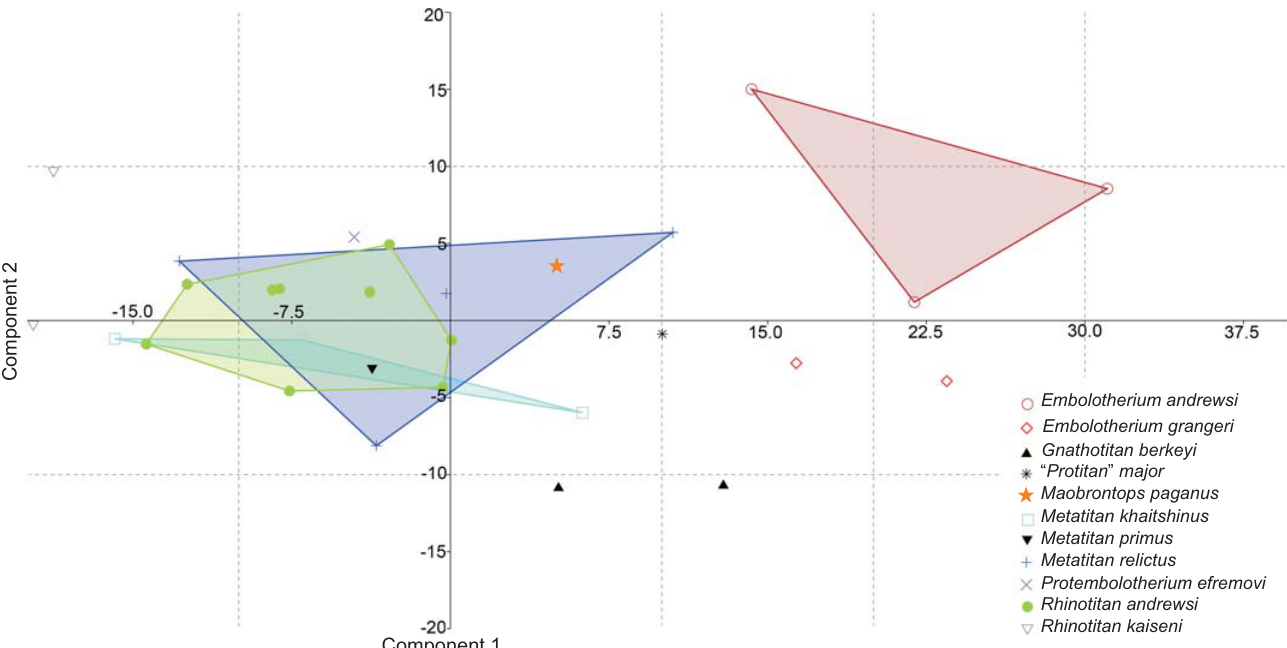
Fig. 4. Principal component analysis of 32 specimens of ten species of Embolotheriita based on measurements of P4 and M1–2 (see SOM